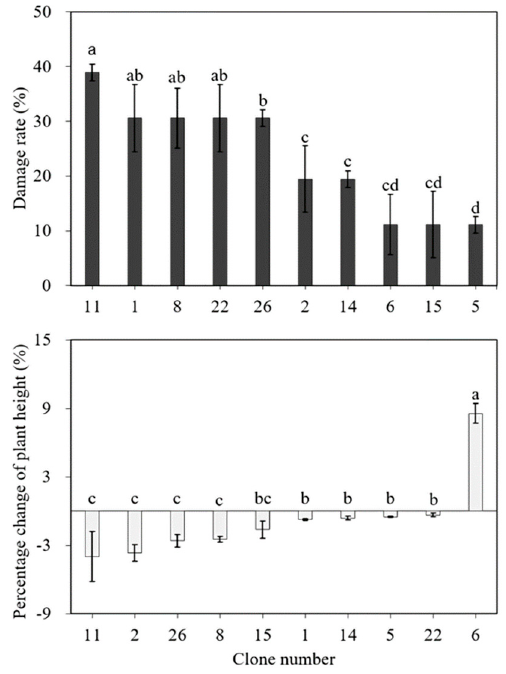
Figure 2. Effect of high-temperature treatment (32.5 °C) on plant height, and damage rate in various clones of Cnidium officinale . Different letters indicate mean values which are significantly different at p < 0.05 according to Duncan’s multiple range test ( n = 10).